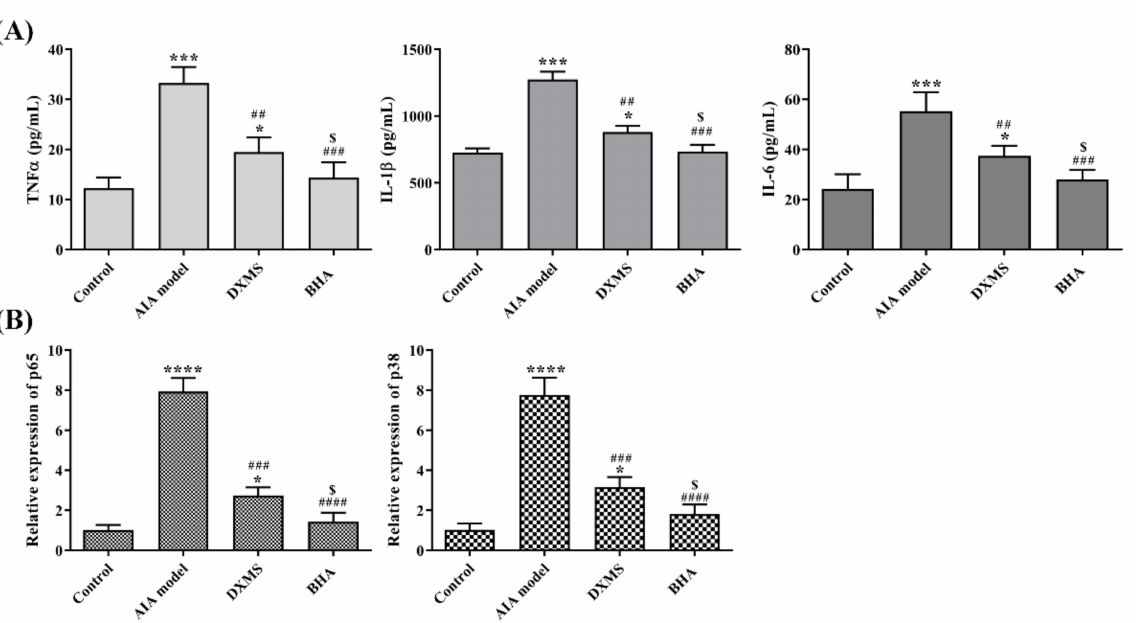
Figure 6. ( A ) The effects of BHA on cytokine levels in the inflammatory joint tissues in AIA rats. At the endpoint, the rats were sacrificed, and the protein levels of TNF- α , IL-1 β and IL-6 in the ankle joint tissues were determined via ELISA assays. ( B ) The relative mRNA expression of inflammatory factors in the joint tissues obtained from AIA rats. The rats were euthanized at the endpoint of this experiment, and the expressions of p38 and p65 in ankle joint tissues were assayed by quantitative PCR. Values are shown as the mean ± SEM. * p < 0.05, *** p < 0.001 and **** p < 0.0001 were relative to the control group; ## p < 0.01, ### p < 0.001 and #### p < 0.0001 were relative to the AIA model group; $ p < 0.05 were relative to the DXMS treatment